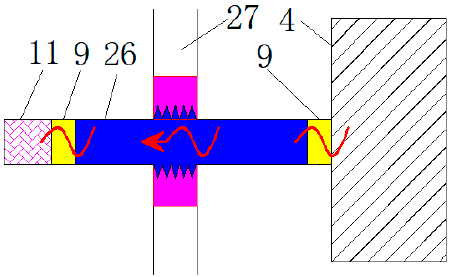
Figure 2. Schematic diagram of AE signal from waveguide wave. 11—AE sensor; 9—coupling agent; 26—waveguide rod; 27—chamber wall; 4—specimen.